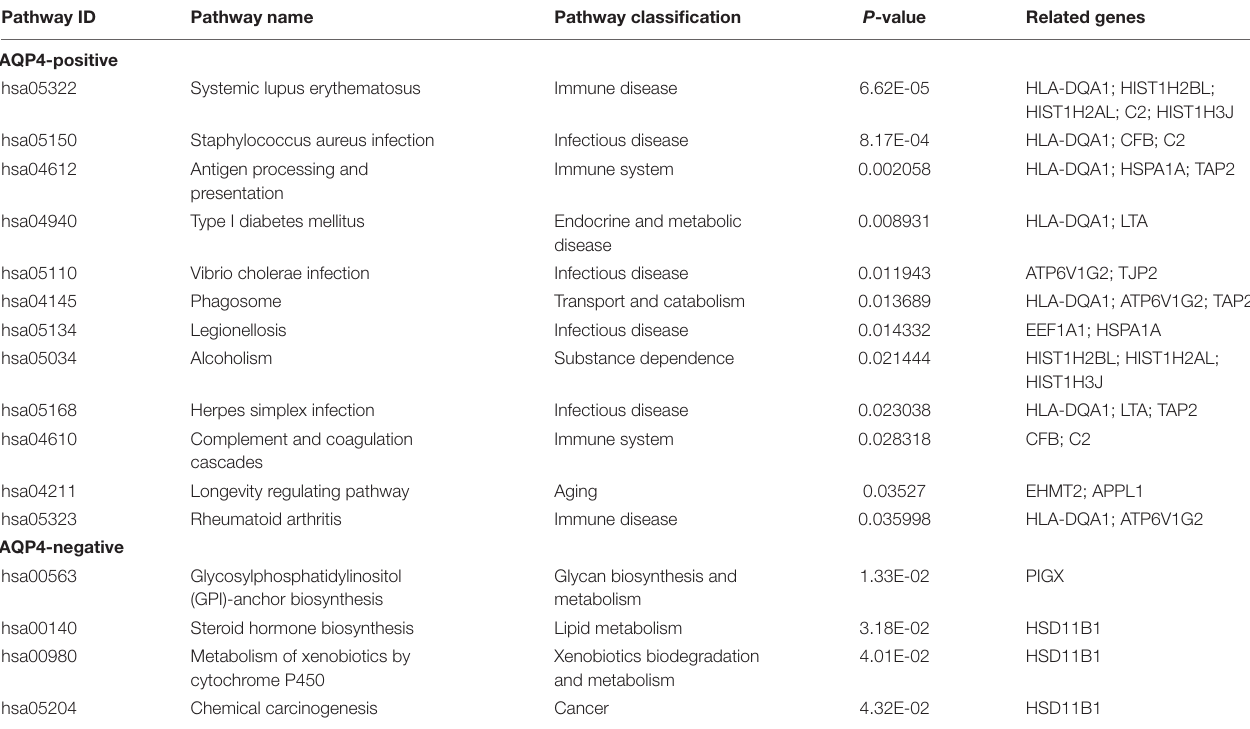
FIGURE 3 | Network of known and predicted interactions between proteins encoded by NMOSD potential susceptibility genes were identified by GWAS of AQP4-negative NMOSD. TABLE 4 | Significant KEGG pathways of AQP4-positive and negative with P < 0.05 by pathway analysis of NMOSD GWAS. Pathway